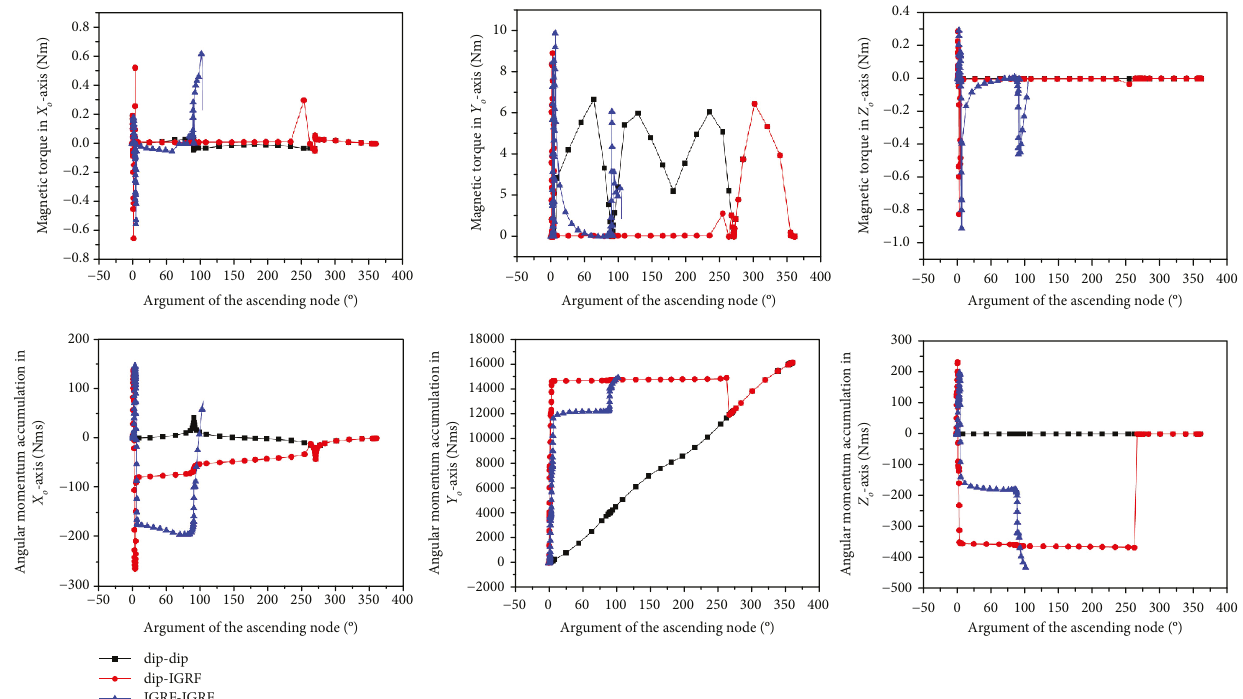
Figure 10: Magnetic torque and angular momentum accumulation (orbital coordinates) in the circular orbit (1950km) under equations (10) and (18) (example